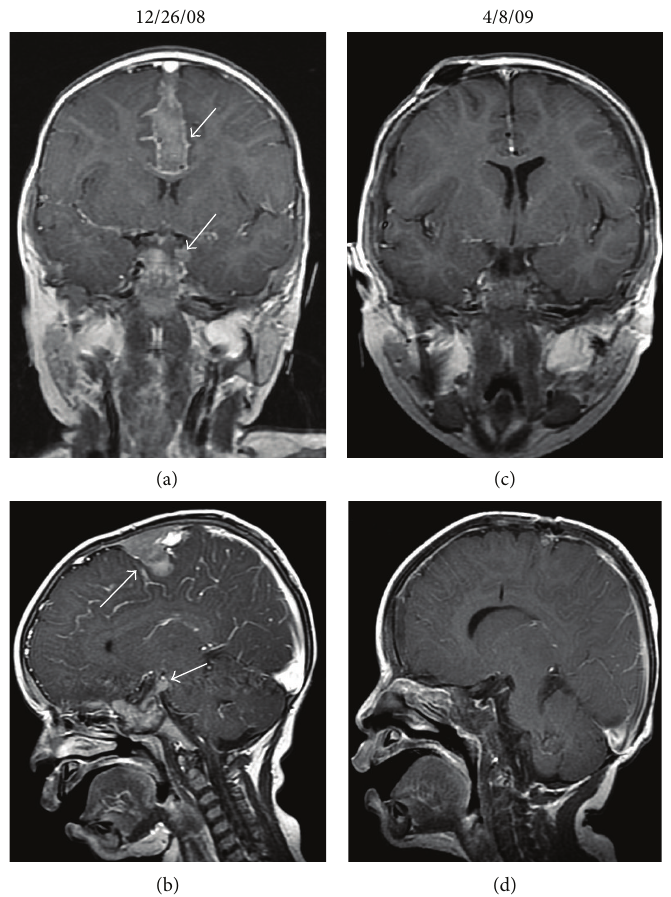
Figure 2: (a) 12/26/08 MRI coronal T1 postgadolinium image demonstrates a dural-based mass along the falx with heterogeneous enhancement (arrow). (b) 12/26/08 MRI sagittal T1 post-gadolinium image demonstrates the mass along the falx and an enhancing focus in the suprasellar cistern (arrows). (c) 4/8/09 MRI coronal T1 post-gadolinium image shows resolution of the previously identified enhancing masswithinthefalx.AnOmmayareservoirhasbeenplacedintheinterim.(d)4/8/09MRIsagittalT1post-gadoliniumimageshowsresolution of previously seen enhancing anterior falx and resolution of the suprasellar mass.